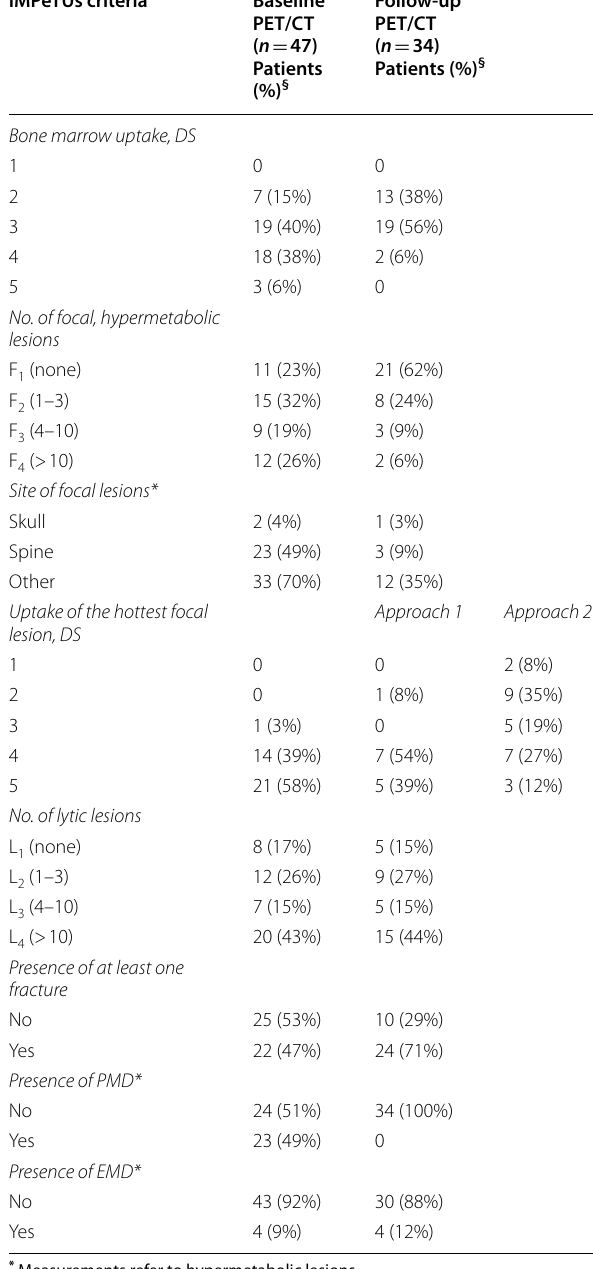
Table 2 PET/CT results after application of